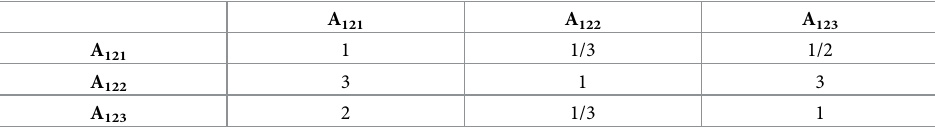
Table 9. Pairwise comparison matrix of the brownfield geographical condition